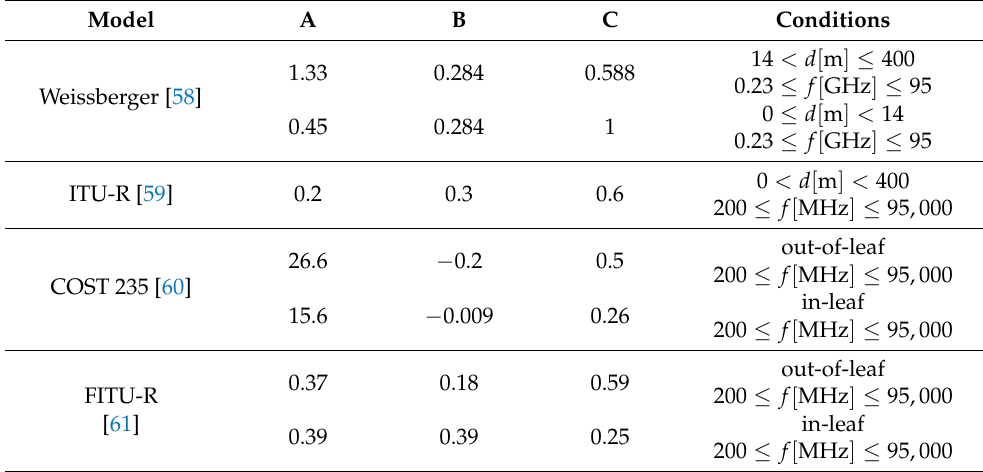
Table 4. Empirical constants for MED models.